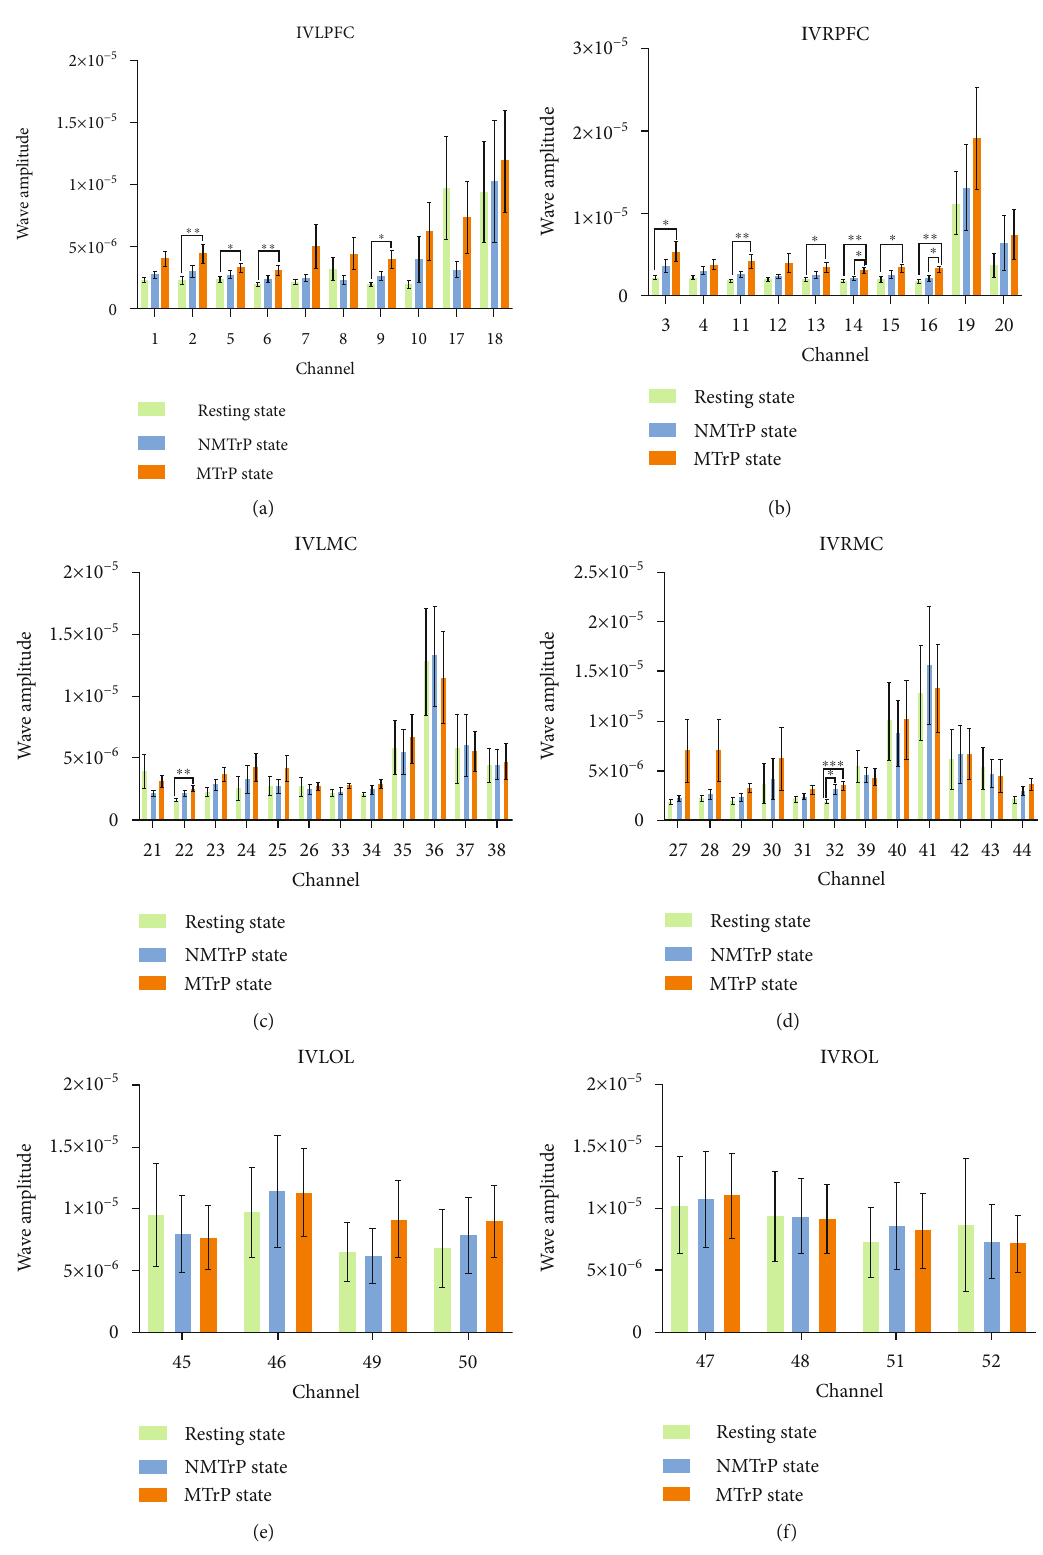
Figure 4: Comparison of wavelet amplitude (WA) changes among three stages in the frequency interval IV: PFC (a and b), MC (c and d), and OL (e and f). Error bars are mean ± s : e : m . ∗ : p < 0 : 05 ; ∗∗ : p < 0 : 01 ; ∗∗∗ : p < 0 : 001 . MTrP: myofascial trigger point; NMTrP: nonmyofascial trigger point; L: left; R: right; PFC: prefrontal cortex; MC: motor cortex; OL: occipital